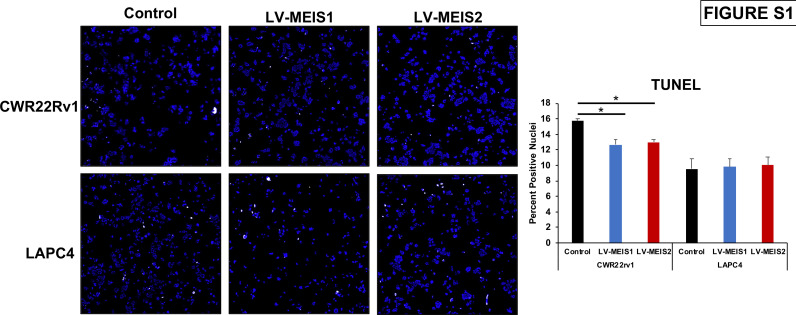
Decreased cell number with exogenous MEIS1 or MEIS2 expression is not the result of increased cell death.Representative images (left) and quantitation (right) of terminal deoxynucleotidyl transferase (TdT) dUTP nick-end labeling (TUNEL) assay on CWR22Rv1 and LAPC4 cells expressing control, LV-MEIS1, or LV-MEIS2 48 hr after plating in full growth media in a 96-well plate. Nuclei are stained with DAPI (blue), and TUNEL assay signal is visualized with Alexa Fluor 647 (white). Complete wells were imaged at 4X, images for each well were stitched together, and TUNEL-positive nuclei were counted manually using ImageJ. Quantitation reflects mean (technical replicates, n = 4) and SEM. *Student’s t-test p<0.05.